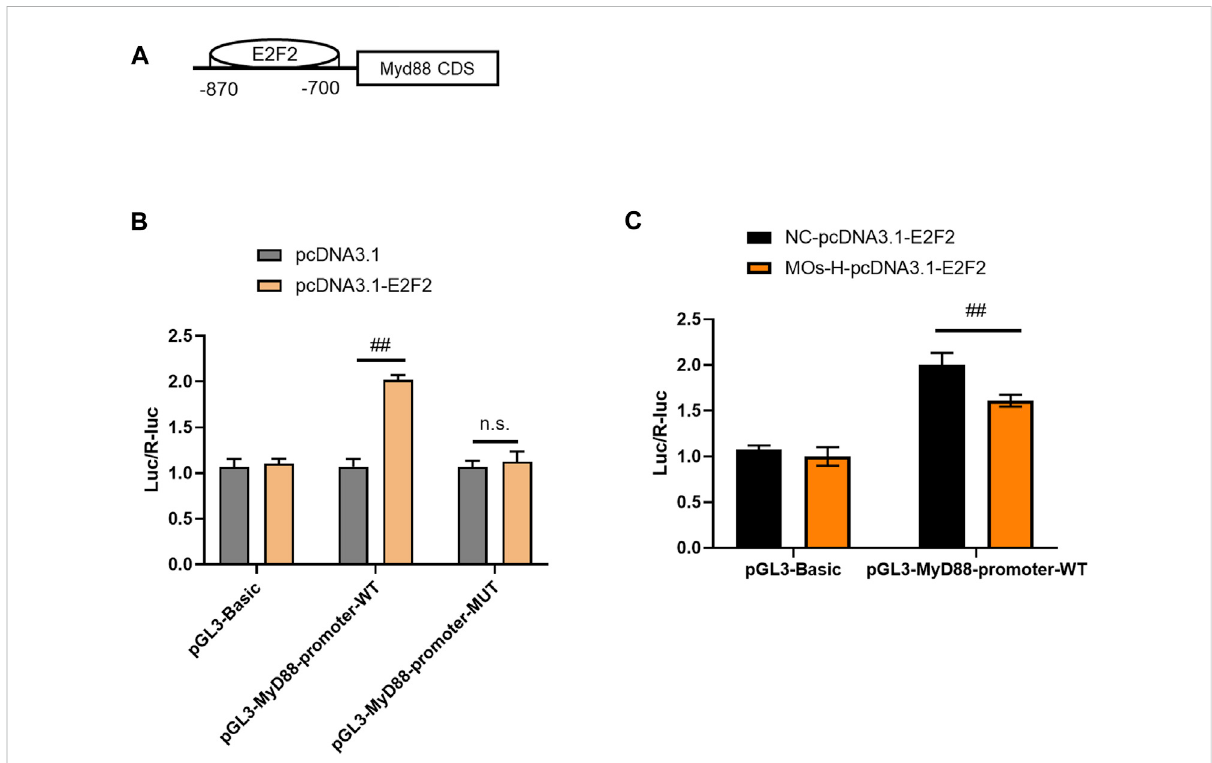
FIGURE 5 MOs inhibit E2F2 binding to MyD88 in HEK239T cells. (A) Schematic representation of the E2F2 binding motif in the MyD88 promoter. (B) Luciferase reporter gene assay of E2F2 and MyD88. (C) Effects of MOs (50 mg/kg) on E2F2 binding to MyD88 in the HEK239T cells. Data are expressed as means ± SD ( n = 3). ## p < 0.01; n. s. not signi fi